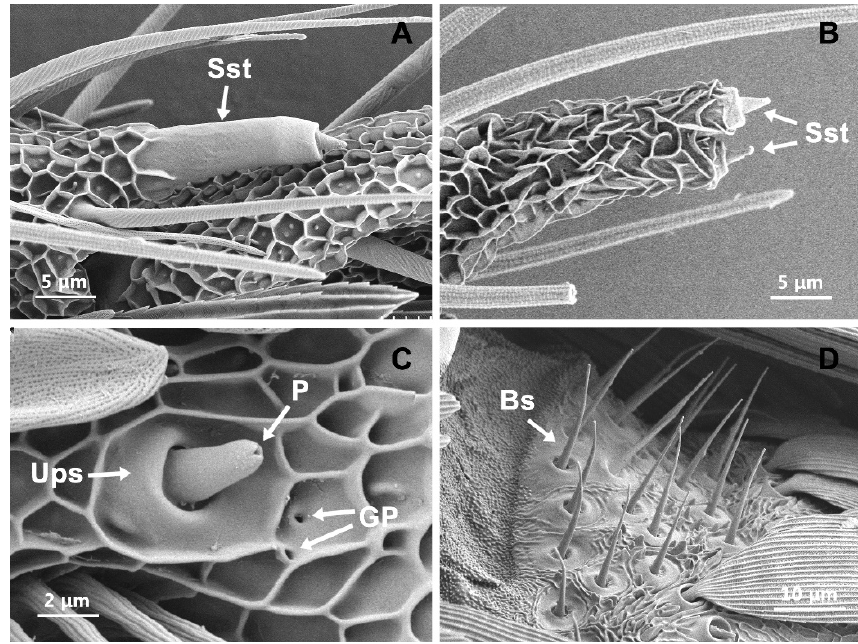
Figure 9. Scanning electron micrographs of sensilla styloconica (Sst), uniporous peg sensilla (Ups) and Böhm sensilla (Bs). ( A ) The surface structure of Sst on flagellar segment; ( B ) the surface structure of Sst on last flagellar segment; ( C ) the surface structure of Ups; ( D ) the surface structure of Bs. GP: glandular pore; P: pore.